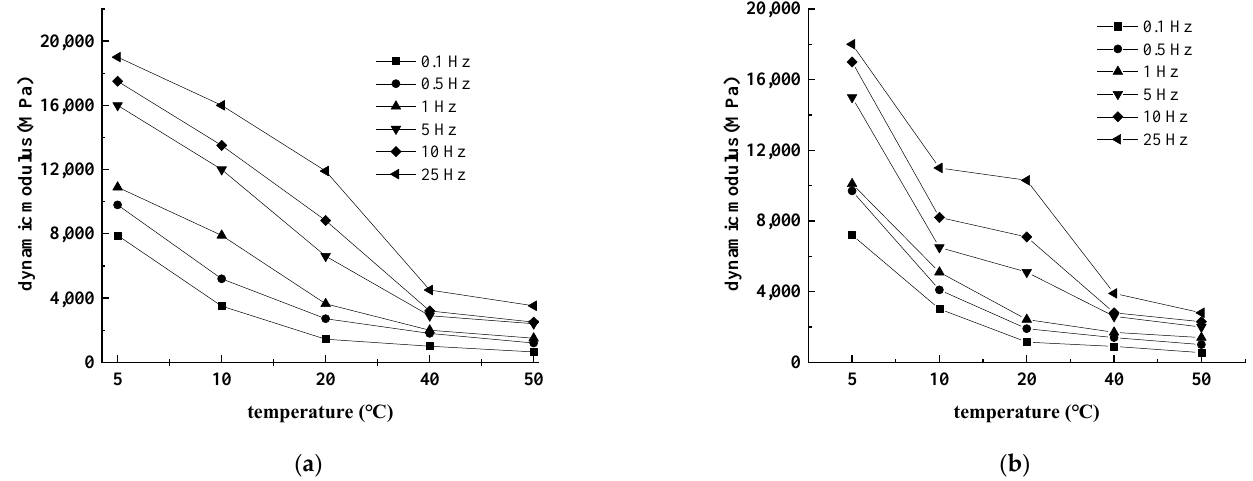
Figure 10. Relationship between the dynamic moduli and loading frequencies of different asphalt mixtures: ( a ) rubber- powder-modified asphalt mixture; ( b ) SBS-modified asphalt mixture.